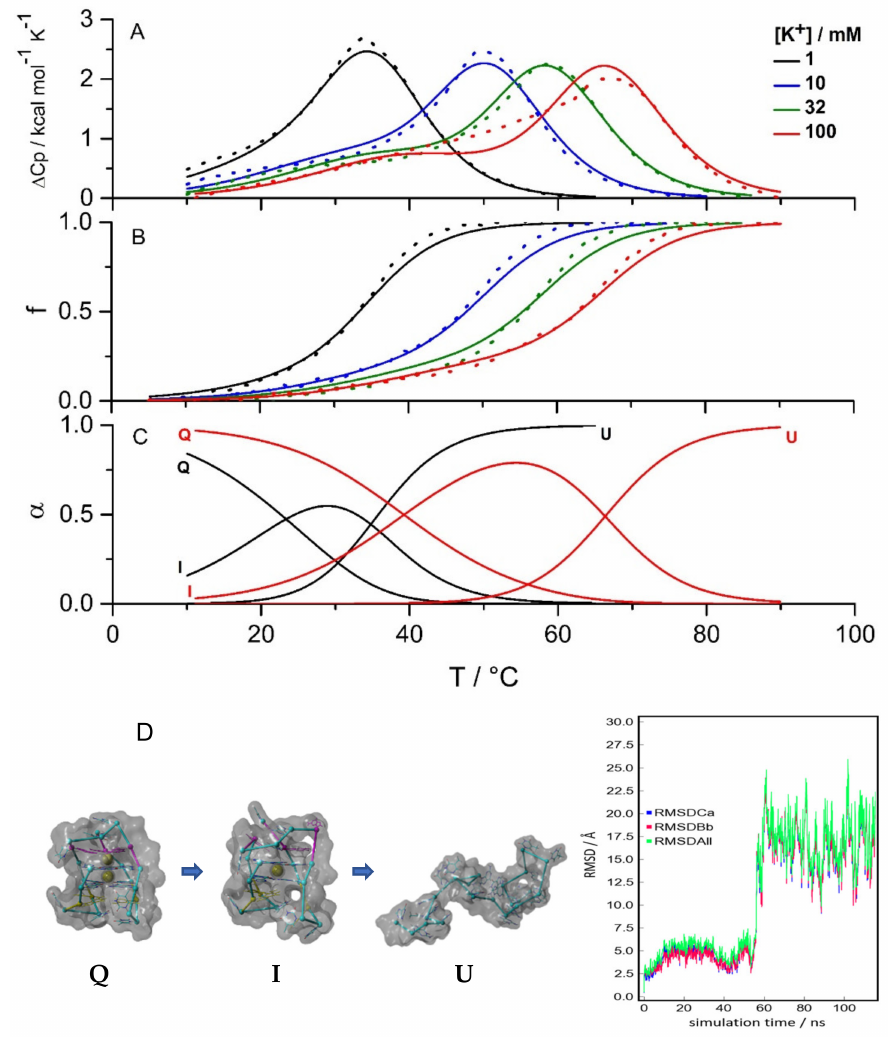
Figure 3. 22GT unfolding monitored by DSC ( A ) and CD spectroscopy ( B ; melting curves measured at 290 nm normalized according to Equation (1)) at different [K + ]. The globally fitted Q ↔ I ↔ U model functions (lines) show good agreement with the experimental data (symbols). ( C ) Model-predicted fractions of species at [K + ] = 1mM (black curves) and [K + ] = 100 mM (red curves); ( D ) Structural models of Q, I and U obtained from a molecular dynamic simulation of 22GT. RMSD of 22GT from the starting structure Q (corresponds to structure with PDB entry: 2kf8) during the MD simulation at elevated